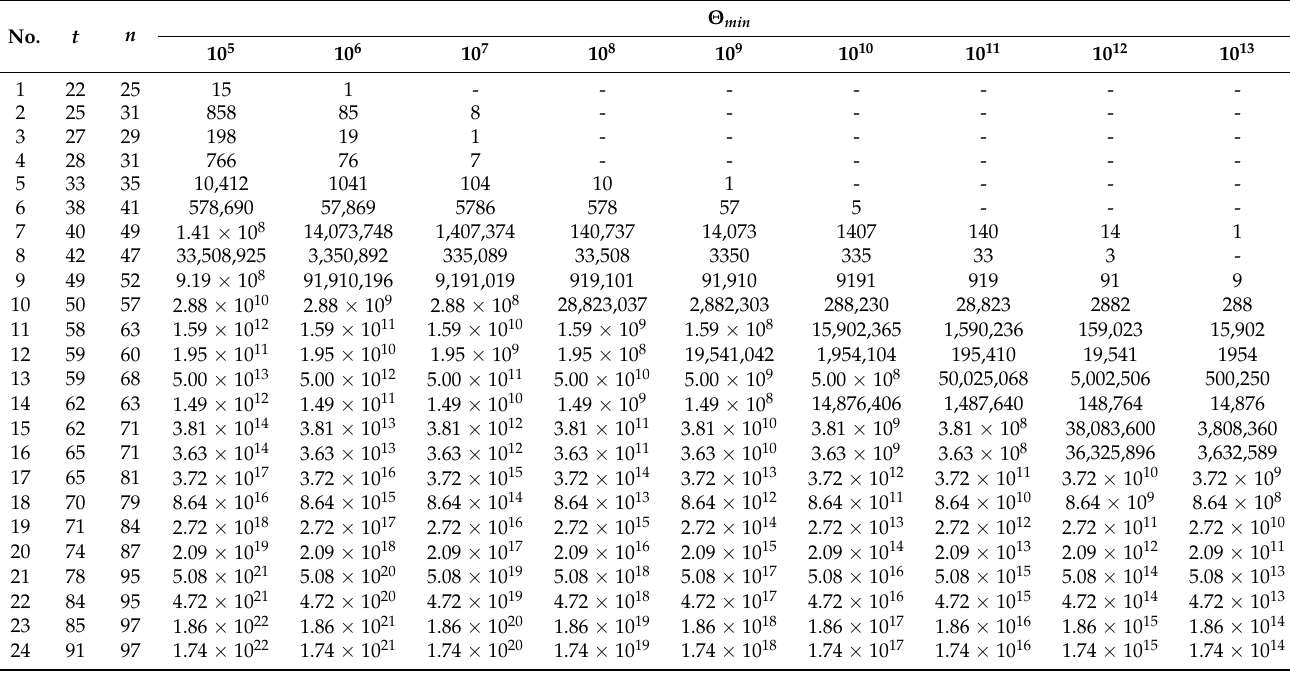
Table 4. Maximum numbers of output channels for test pattern generators of the DT-LFSR-TPG type when the Θ min separation between output channels is